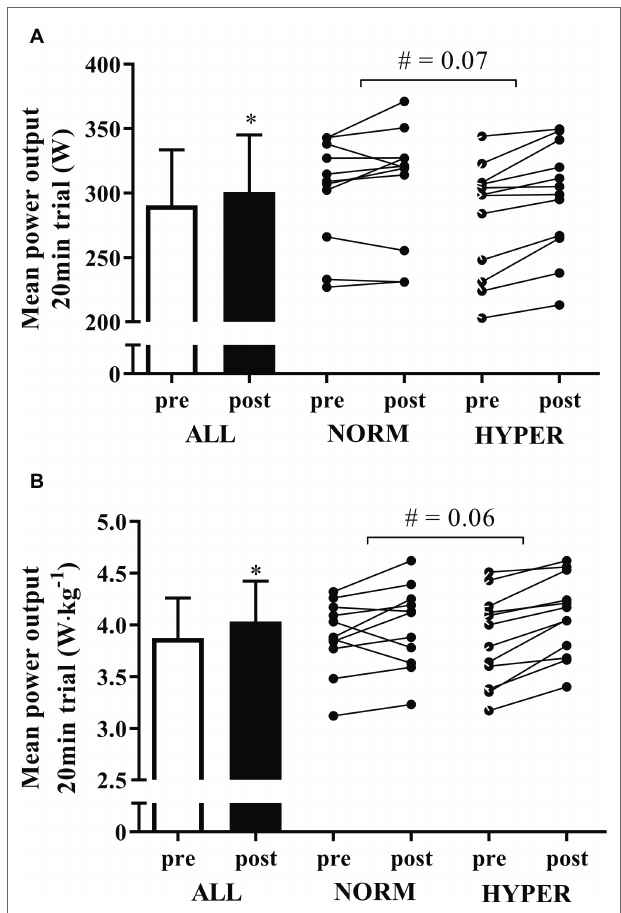
FIGURE 4 | Mean ± SD of the mean power output during the self-paced 20-min cycling trial pre and post intervention expressed in absolute Watts (A) and Watts relative to body mass (B) for all the participants as well as the individual response of the participants in normoxia (NORM) and hyperoxia (HYPER) groups. Note: * p < 0.05, # p between